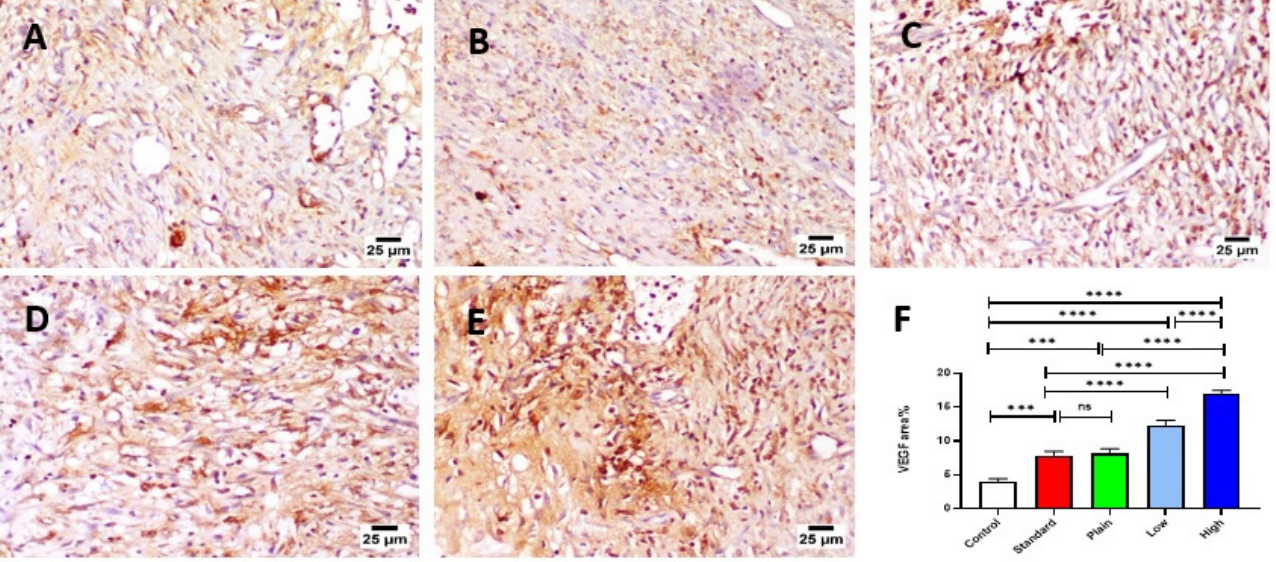
Figure 10. Vascular epithelial growth factor expression on the healed tissue. Microscopic images of skin immunostaining of VEGF. ( A ) Control group, ( B ) standard gentamicin (0.1% garamycin cream), ( C ) plain, ( D ) low, and ( E ) high ( F ) immune expression of VEGF (area%). Data represented as mean ± SE of at least 5 wounds. **** for p < 0.0001, *** for p < 0.001, ns for non ‐ significant.